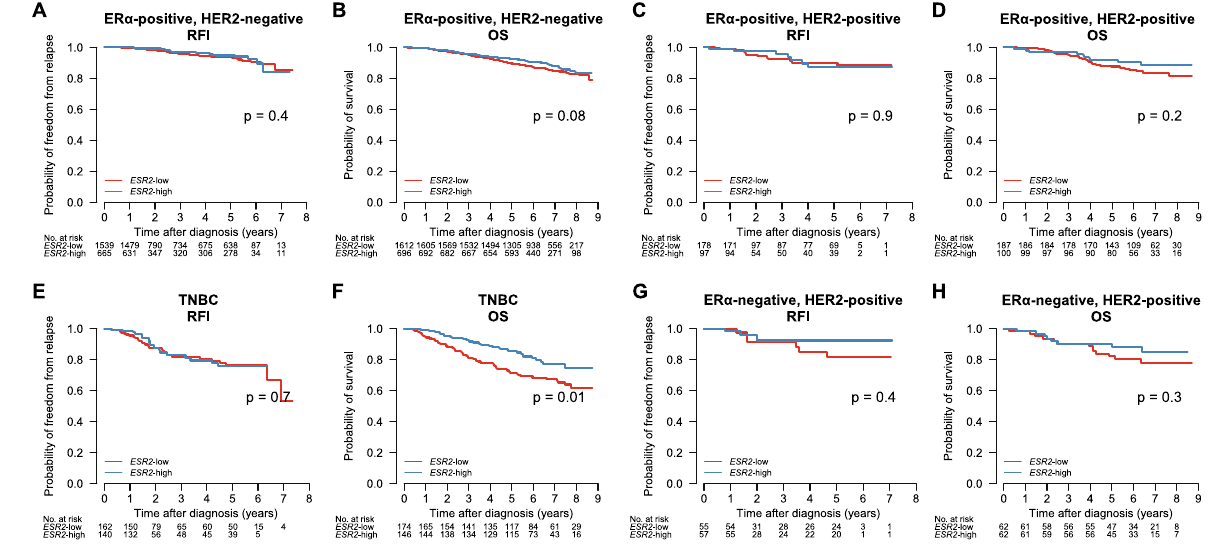
Figure 4. ESR2 expression and association to overall survival (OS) and relapse-free interval (RFI) in the SCAN-B clinical groups. ( A,B ) Patients with ERα-positive, HER2-negative breast cancer; ( C,D ) ERα-positive, HER2-positive breast cancer; ( E,F ) Triple-negative breast cancer (TNBC); and ( G,H ) ERα-negative, HER2- positive breast cancer.